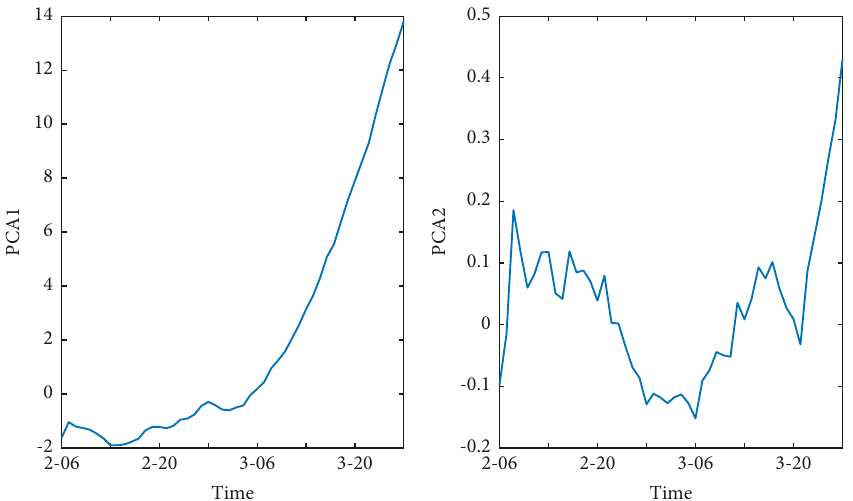
Figure 6: The curves of the first and second principal components over time.